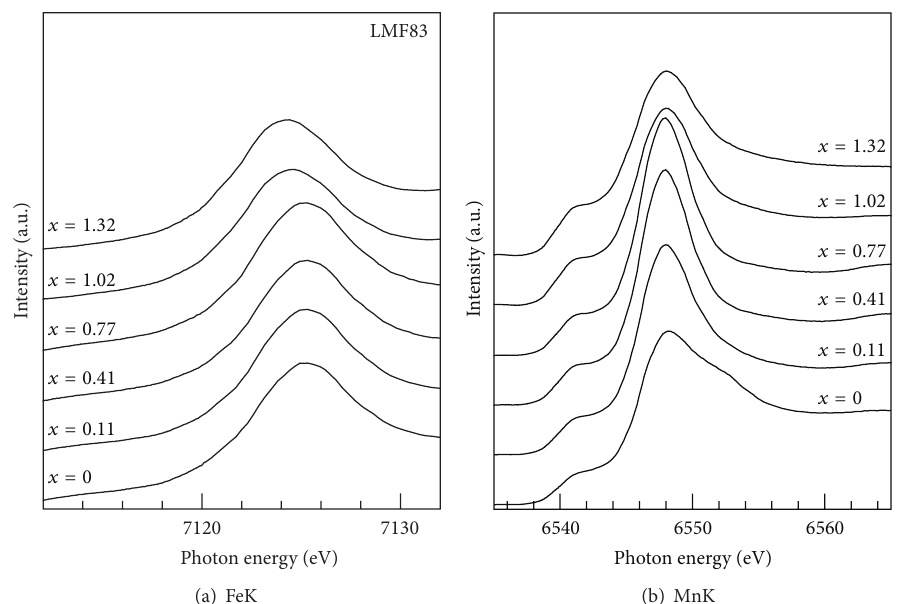
Figure 4: XAS spectra of LMF83 films against 𝑥 around the (a) Fe K- and (b) Mn K-edges (cited from [19]).